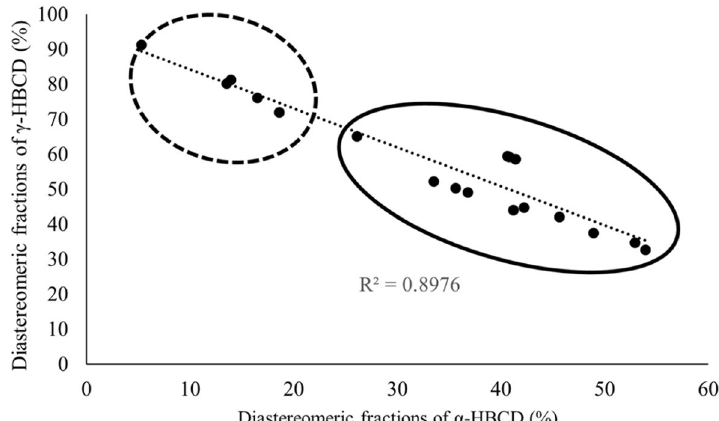
Fig. 4 The relationship between α‑ and γ‑HBCD in soil